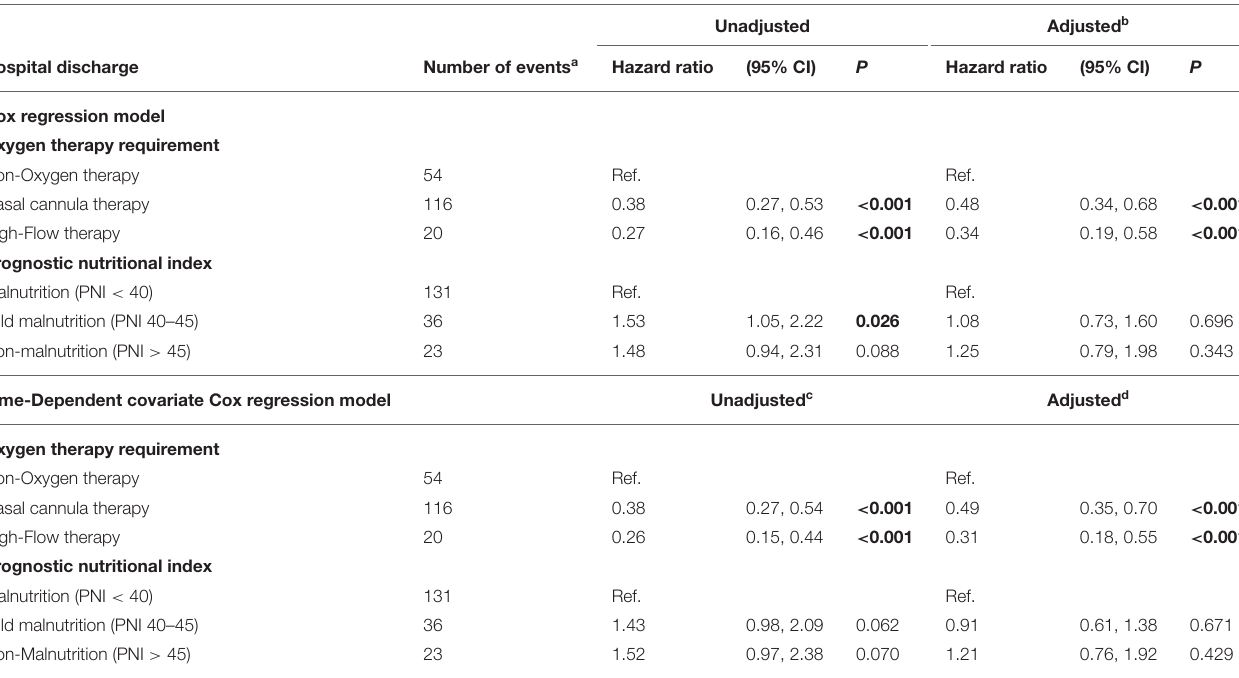
TABLE 3 | Cox regression model and time-dependent covariate cox regression model for primary outcome according to oxygen therapy requirement and PNI